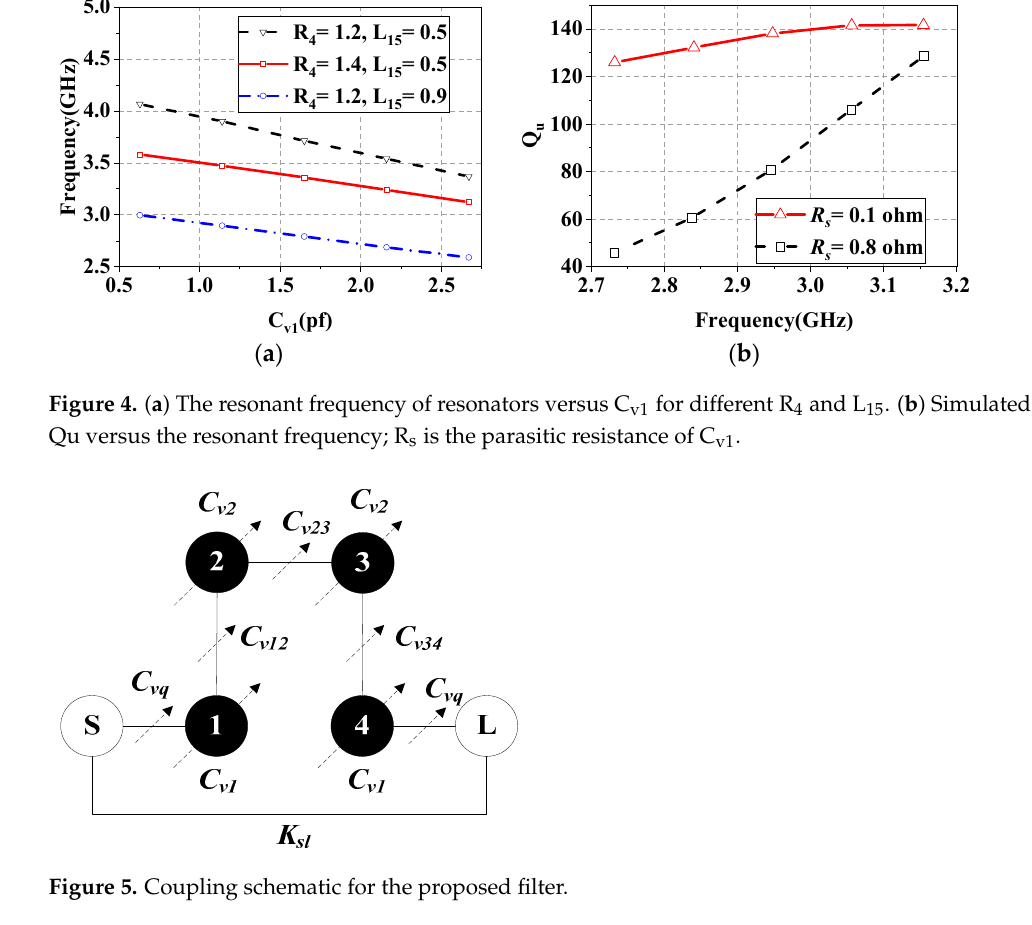
Figure 5. Coupling schematic for the proposed filter.